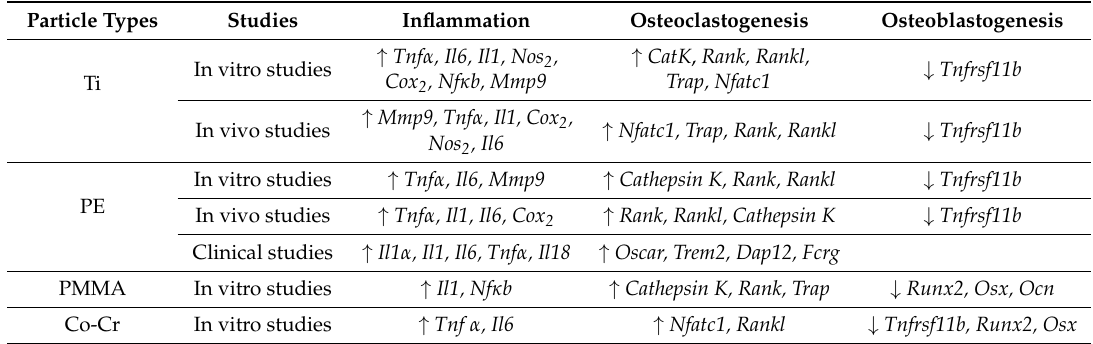
Table 4. Schematic summary of results: major influence/modulation of wear particles on inflammation, osteoclastogenesis and osteoblastogenesis related